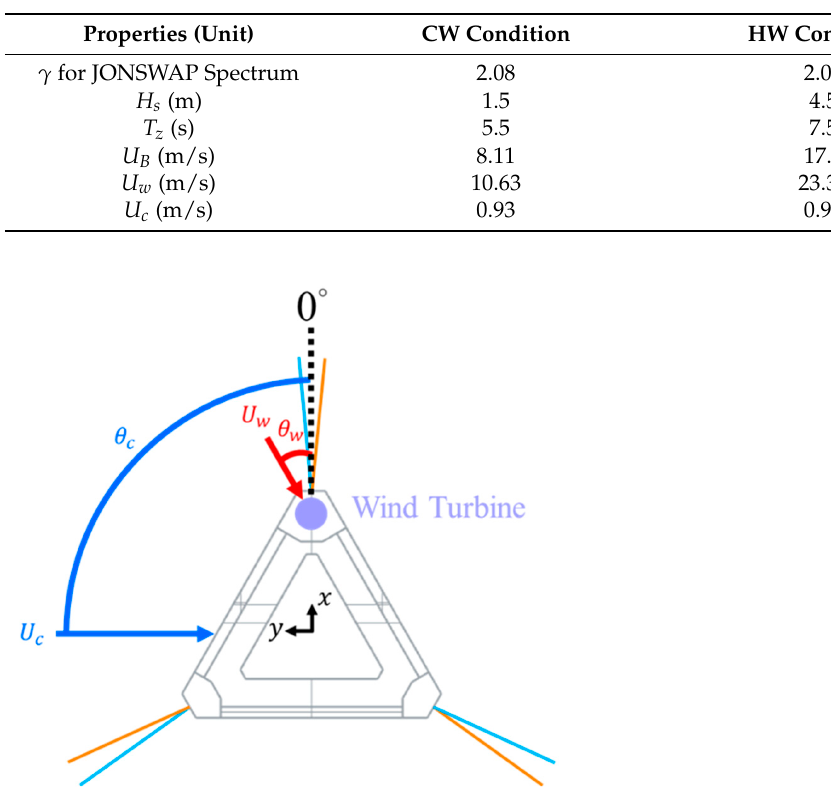
Figure 9. Schematic illustration of wind profile. Table 5. Metocean conditions of two irregular wave conditions.